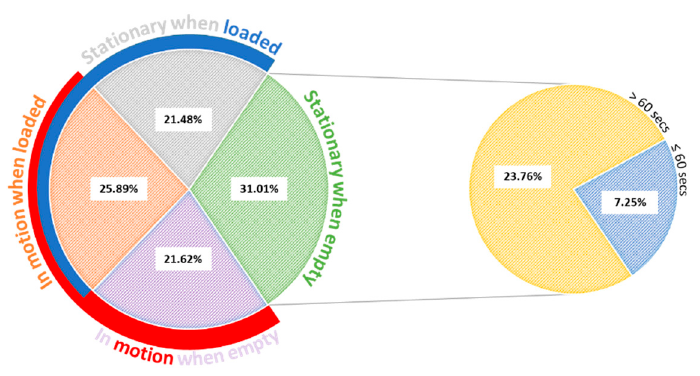
Figure 10. Summary of crane utilization during the entire construction project.